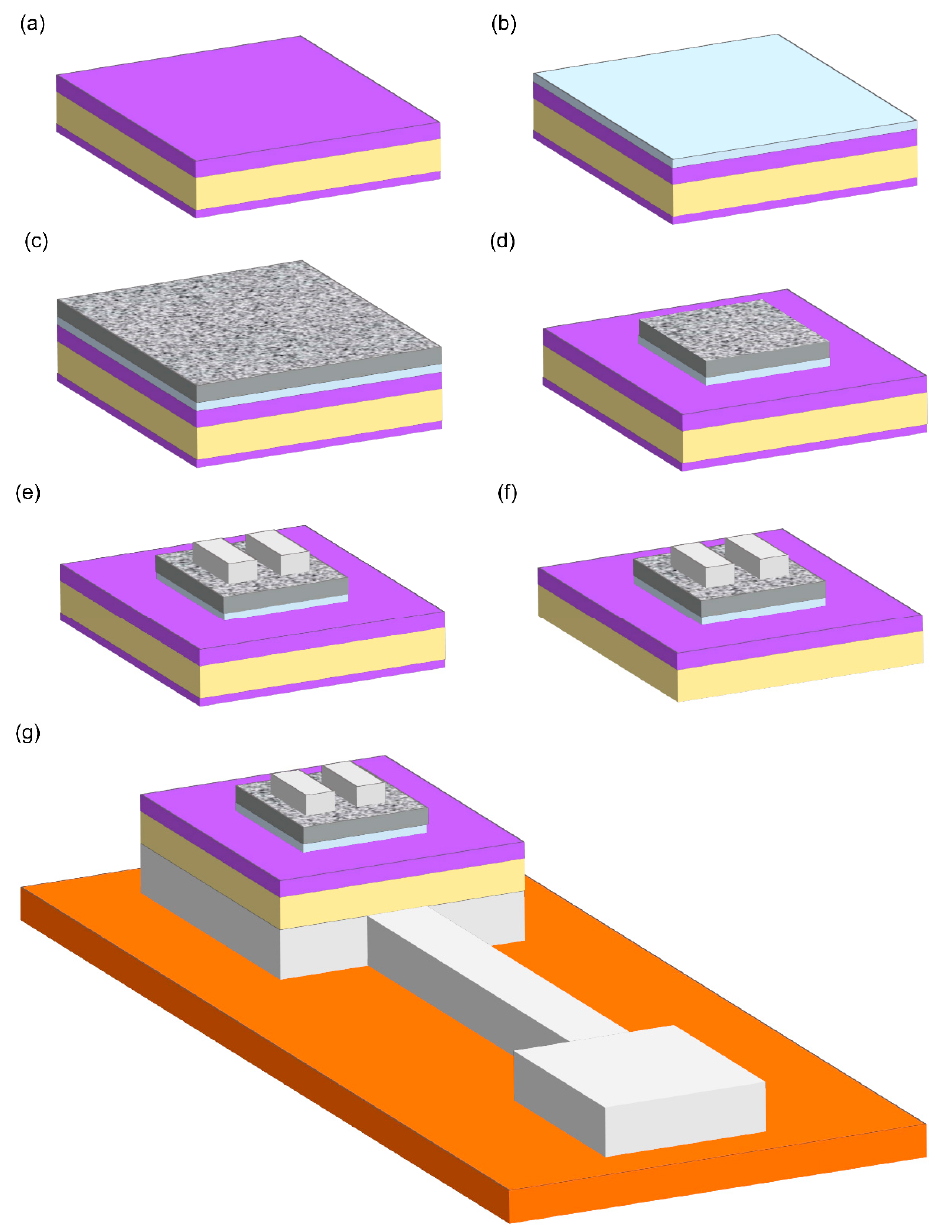
Figure 1. The process with which an improved TFT is fabricated. Fabrication of a traditional TFT differs only in that the steps to remove excess SWCNTs beyond the vicinity of the channel region are omitted for a traditional TFT. One of our two improved TFTs has a 90 nm thick SiO 2 layer, whereas the other has a 300 nm thick SiO 2 layer. Similarly, one of our two traditional TFTs has a 90 nm thick SiO 2 layer, whereas the other has a 300 nm thick SiO 2 layer. ( a ) Start with a <100> p-type Si (280 μ m thick) substrate with a dry SiO 2 (90 nm or 300 nm thick) top surface and a native SiO 2 bottom surface. ( b ) Silanize the SiO 2 top surface with an APTES monolayer (~0.7 nm thick). ( c ) Deposit the SWCNT active layer atop the APTES. ( d ) In the case of an improved TFT only, pattern the SWCNT layer by removing excess SWCNTs not covered by a photolithographically patterned photoresist mask using RF plasma. Traditional TFTs differ from improved TFTs only by omitting this step. ( e ) Print and sinter silver nanoparticle (nAg) ink defining the S and D electrodes atop the SWCNT active layer. ( f ) Scrap away the native SiO 2 from the bottom of the Si substrate. ( g ) Print nAg ink defining the G electrode atop a Kapton polyimide film. Smear additional nAg ink across the scrapped bottom of the Si substrate. Place the sample atop the printed G electrode nAg ink. Sinter the entire assembly.